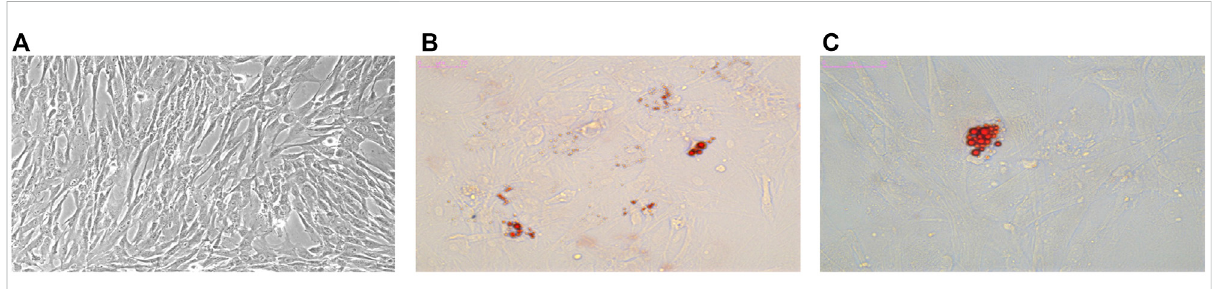
FIGURE 1 Characterization of hMSCs. Osteogenesis and adipogenesis induced differentiation of hMSCs. (A) Morphology of hMSCs. (B) Adipogenic differentiation observed with Oil Red 0 staining (× 200). (C) Adipogenic differentiation observed with Oil Red 0 staining (× 400).